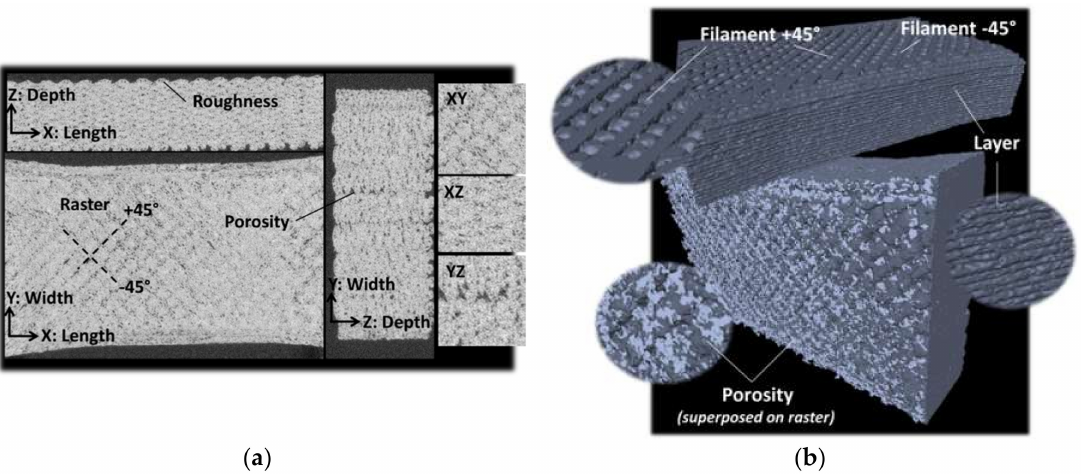
Figure 9. Illustration of X-ray micro-tomography results: ( a ) cross-section views in the three orthogonal planes showing the main features in 3D printed wood-PLA / PHA, ( b ) 3D view of the layer build-up showing the surface texture and the network of process-induced